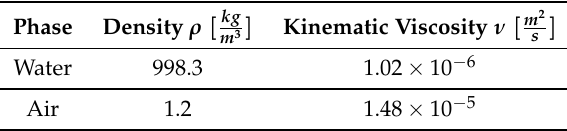
Table 2. Phases transport properties used in this study.